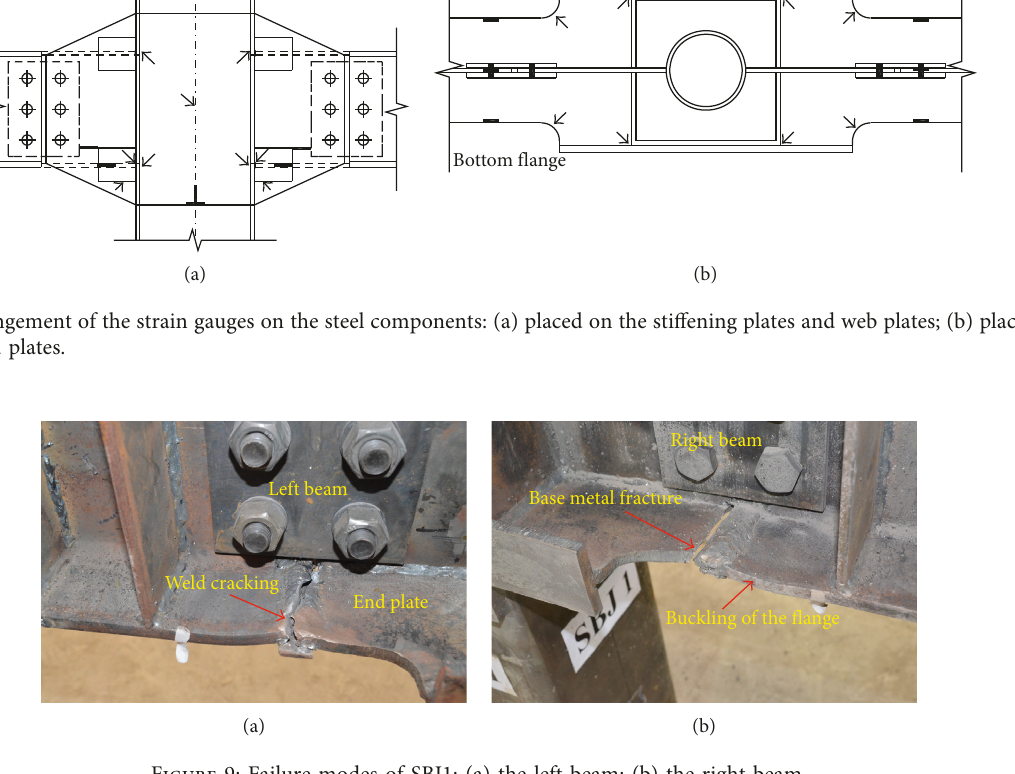
Figure 9: Failure modes of SBJ1: (a) the left beam; (b) the right beam.